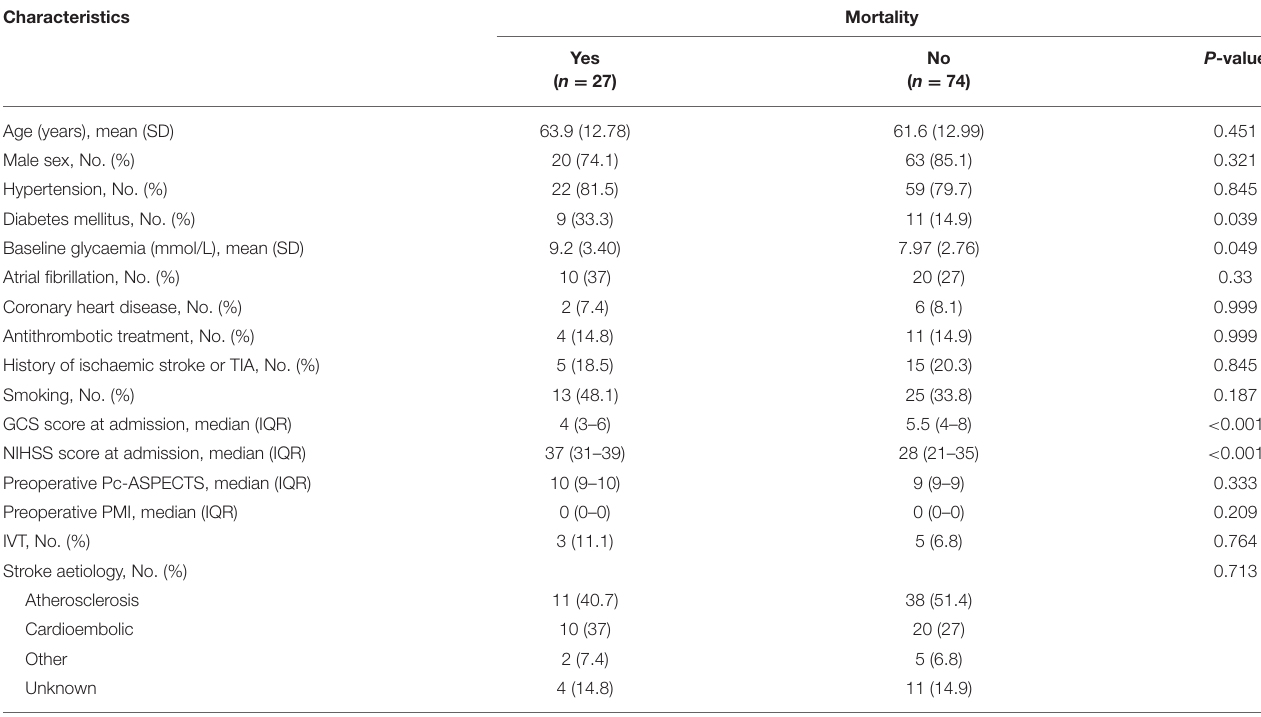
TABLE 2 | Baseline characteristics and mortality.